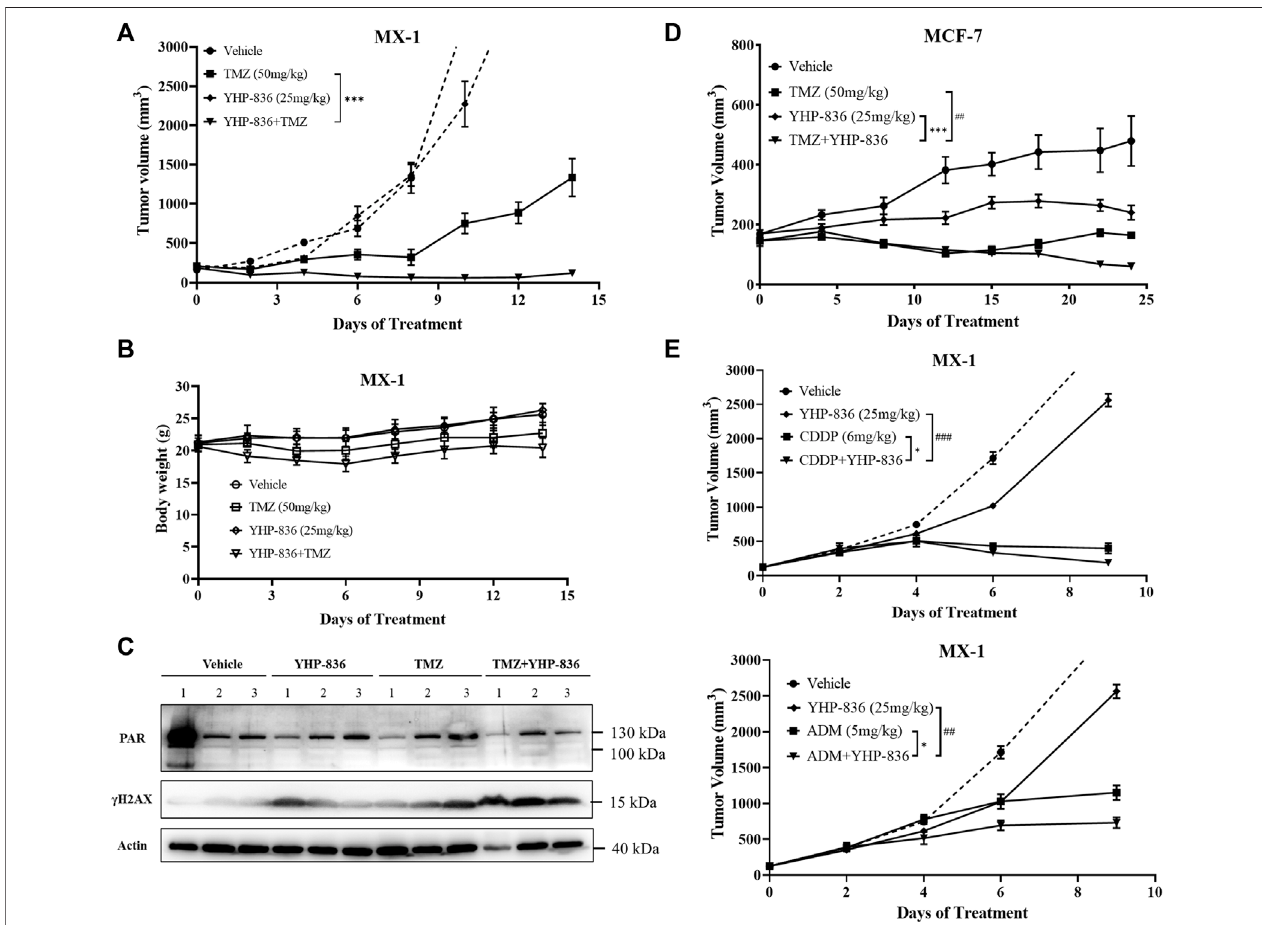
FIGURE 6 | YHP-836 enhanced the antitumor activity of chemotherapy agents in the breast cancer xenograft model. (A) Antitumor activity of the combination of YHP-836andTMZinanMX-1subcutaneousxenograftmodel. t -test,*** p < 0.01,comparedwiththeTMZgroup.Dataarepresentedasmean±SD, n =7. (B) Thebody weight of mice in an MX-1 subcutaneous xenograft model. Data are presented as mean ± SD, n = 7. (C) Levels of PAR and γ H2AX in tumor tissues from the MX-1 xenograftmice model.Numbersrepresentthreeindependent xenografttumorsineachgroup. (D) Antitumor activity ofthecombinationofYHP-836and TMZinan MCF-7 subcutaneous xenograft model. ANOVA analysis, *** p < 0.01, combination group vs. YHP-836 group; ## p < 0.01, combination group vs. TMZ group. Data are presentedasmean ±SEM, n =5. (E) Antitumor activity ofthecombinationofYHP-836 and CDDP orADM inanMX-1 subcutaneousxenograftmodel. ANOVAanalysis, * p < 0.05, combination group vs. CDDP or ADM group; ## p < 0.01, ### p < 0.001, combination group vs. YHP-836 group. Data are presented as mean ± SEM, n =